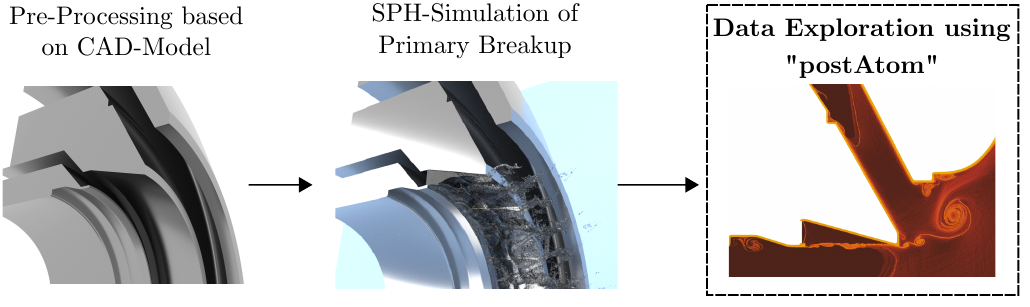
Figure 1. Virtual fuel spray nozzle test rig. SPH: smoothed particle